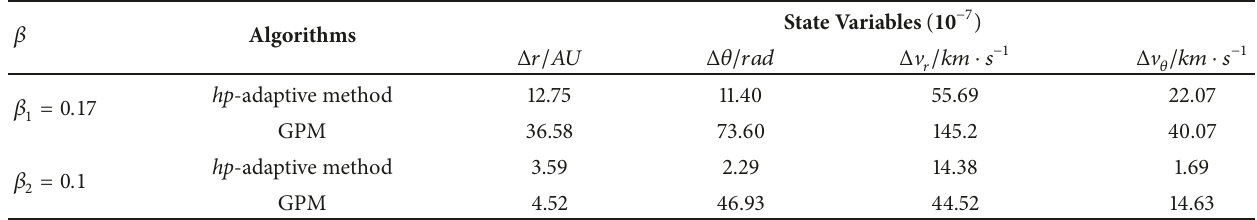
Table 2: Average residuals between the state variable values and the real